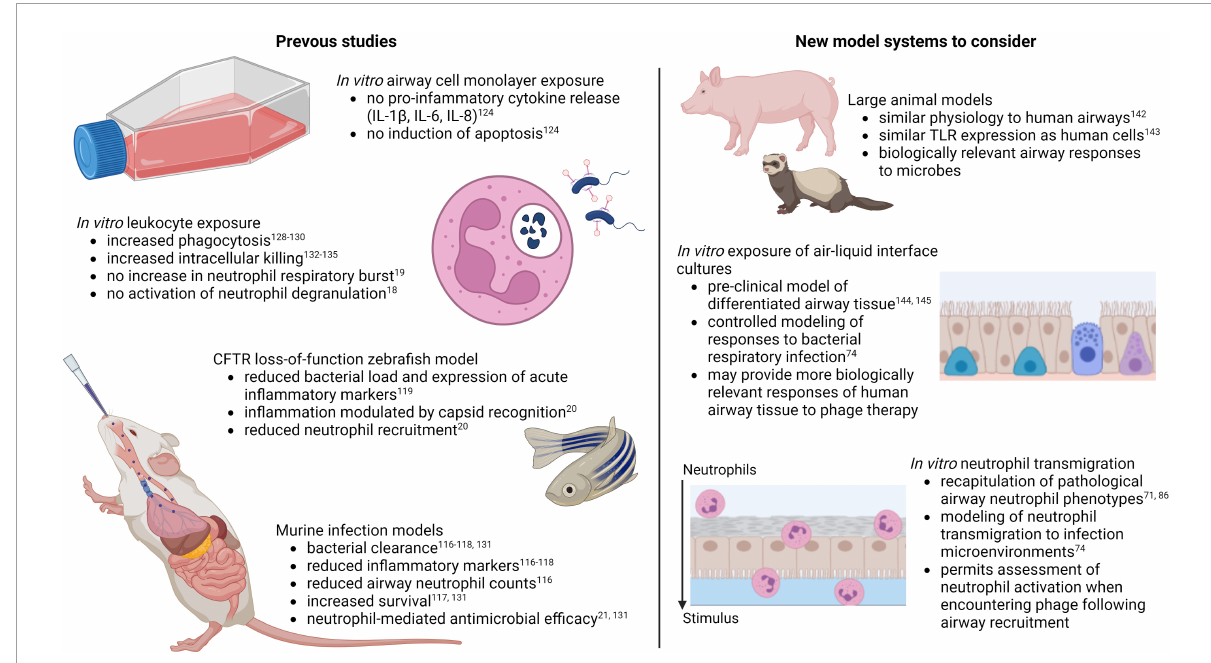
FIGURE2 Models for assessing innate immune responses to pulmonary phage therapy (created with